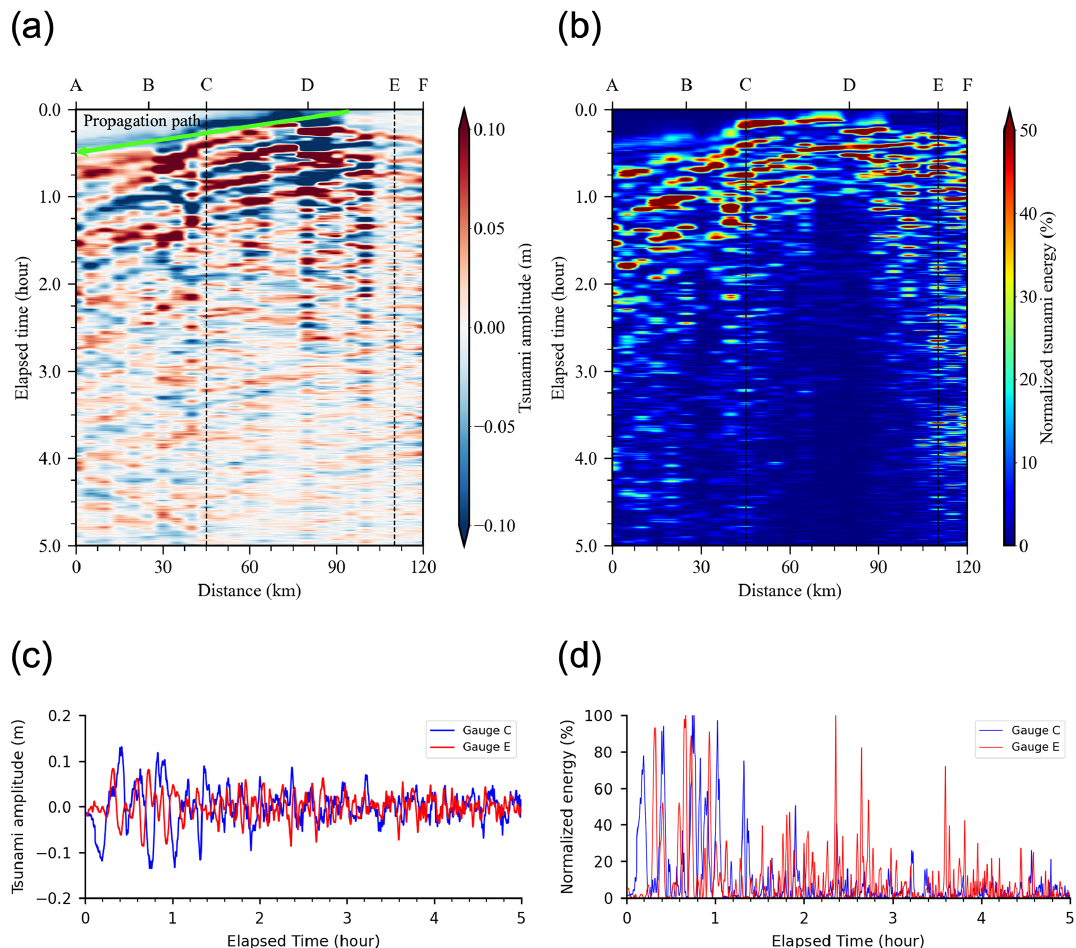
Figure 27. Time–distance diagram of the (a) tsunami wave and (b) normalized energy along the 20m bathymetry contour from numerical wave gauges A to F and time series measurements of the (c) tsunami amplitude and (d) normalized energy at numerical wave gauges C and E. The dashed black lines indicate the distances of numerical wave gauges C and E from A. For interpretation of the references, please refer to Fig.